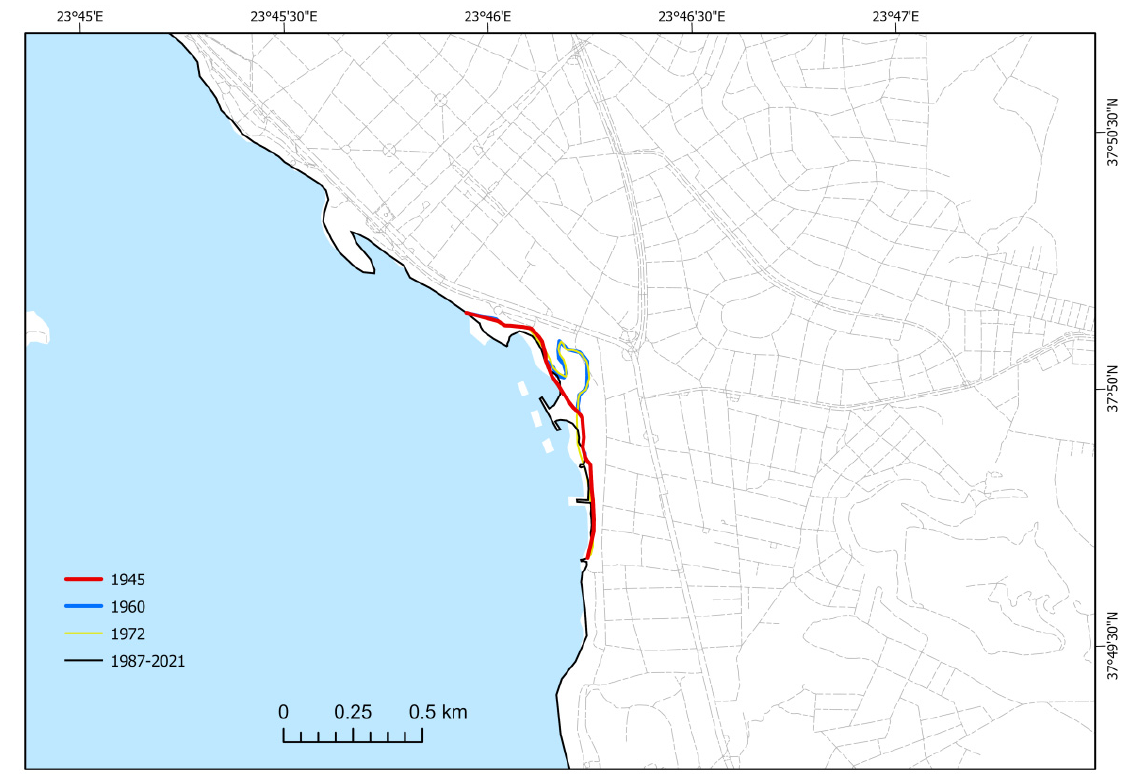
Figure 7. The locations of the coastline from 1945 to 2021 in the coastal zone of Voula. From 1945 to 2021 the length of the coastline increased by 31%. The extension of the artificial land covers an area of 0.02 km 2 (Tables 2 and